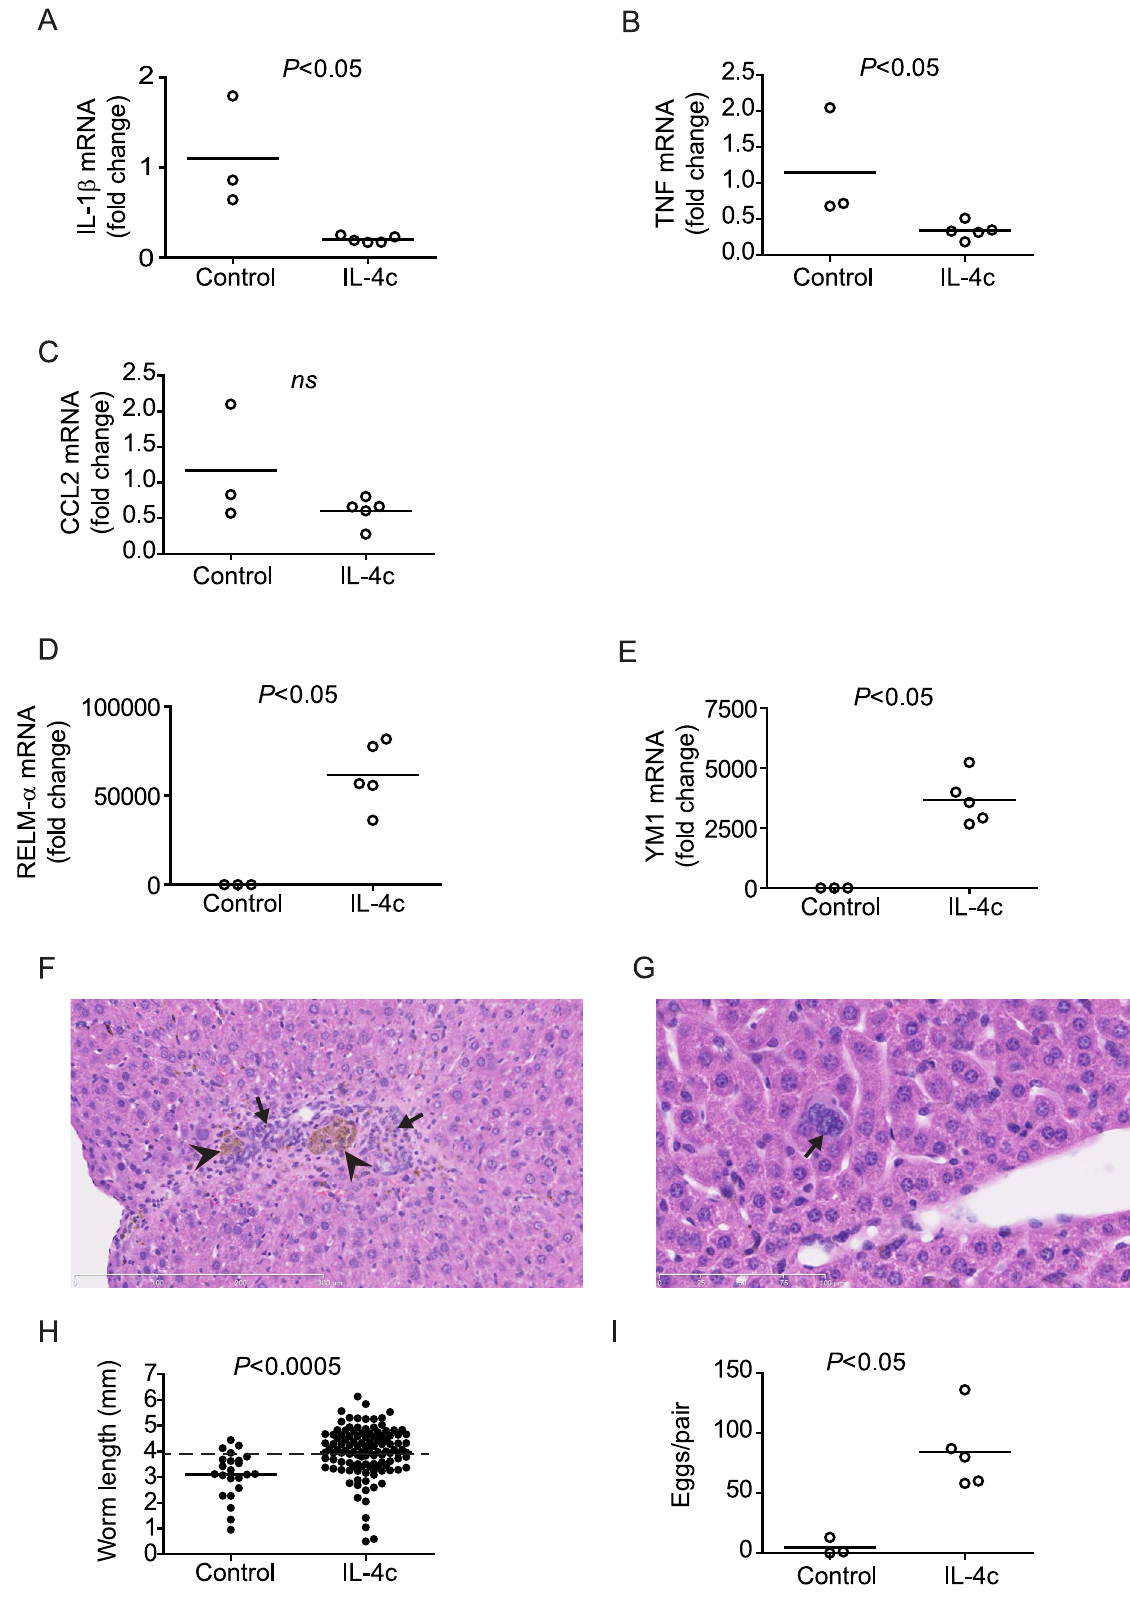
Figure 7. Chronic administration of IL-4 restores regulation of pro-inflammatory cytokine transcription and parasite development in infected RAG 2 / 2 mice. Groups of S. mansoni -infected RAG 2 / 2 mice were repeatedly treated throughout pre-patent infection with IL-4 complex (IL-4c), as described in Materials and Methods. At 6 weeks p.i., mice were euthanized, parasites perfused from the portal tract and spleens (A–C) and